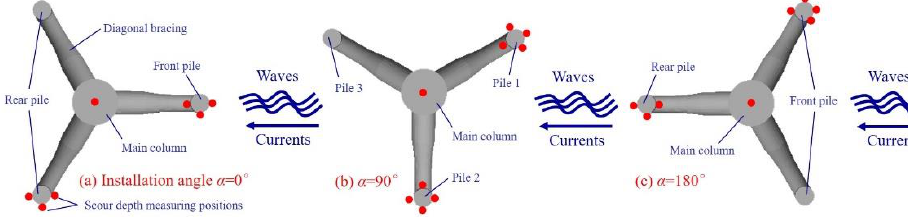
Figure 1. Schematic of the experiment system.